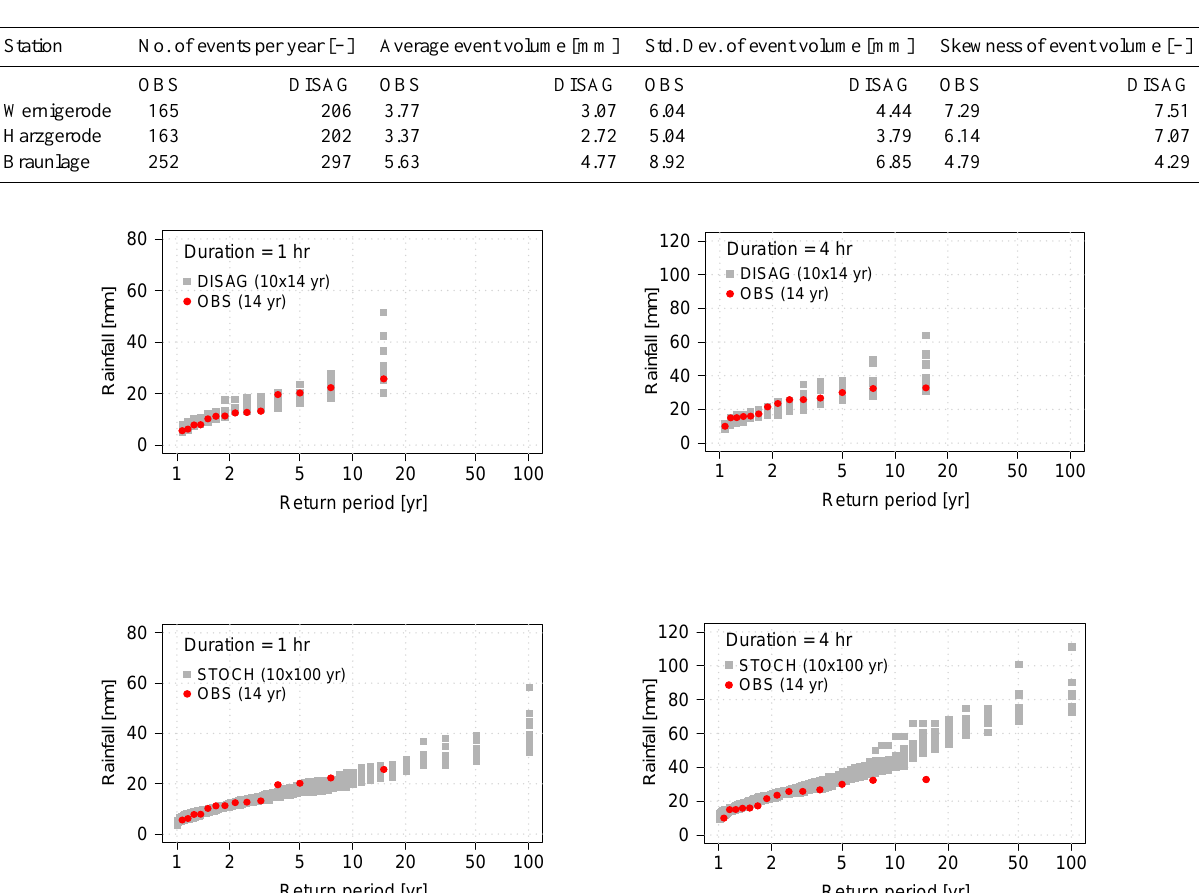
Fig. 7. Empirical probability distributions of annual maximum precipitation from OBS, DISAG (top row) and STOCH rainfall (bottom row) for the station Harzgerode for 1 and 4h Figure 7 . Empirical probability distributions of annual maximum precipitation from observed (OBS), disaggregated (DISAG, top row) and stochastically generated rainfall (STOCH, bottom row) for the station Harzgerode for 1 hour and 4 hour durations